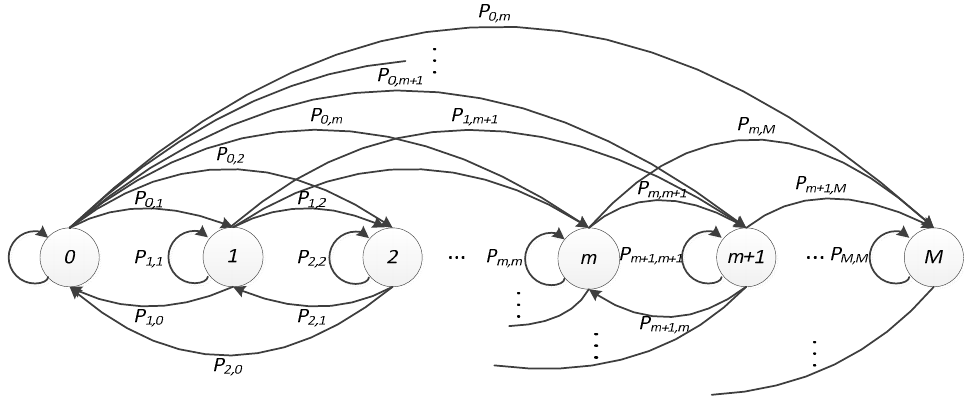
Figure 3. Markov chain for the number of access requests at the beginning of a slot.